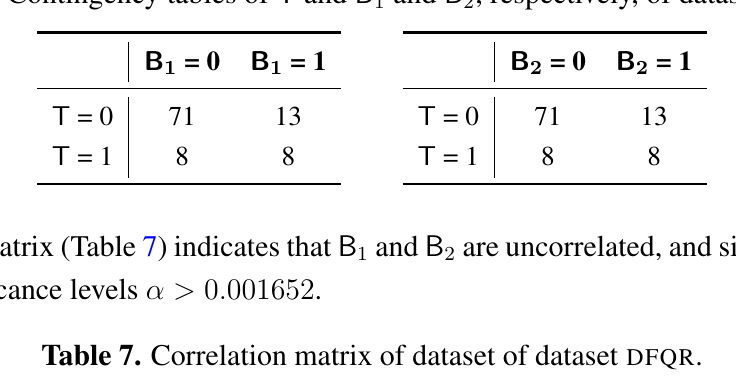
Table 6. Contingency tables of T and B